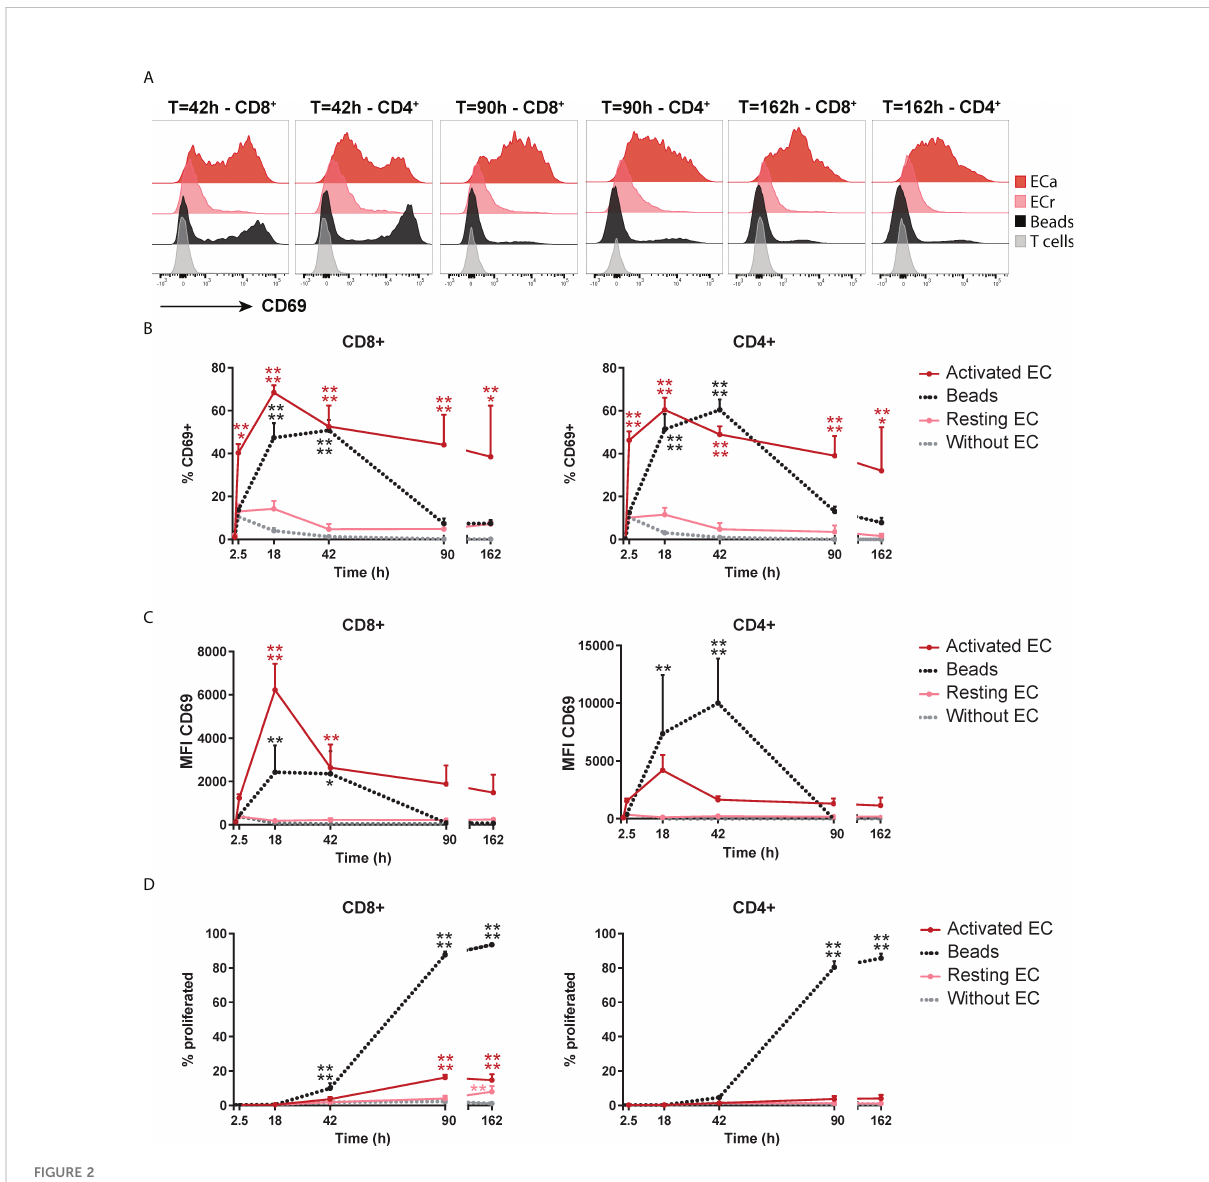
FIGURE 2 Activated EC induce a distinct dynamic of CD69 expression on T cells. HMEC were left unstimulated (resting) or stimulated with 10 ng/mL TNF a and IFN g for 3 days (activated) before addition of FACS-sorted CD3+ T cells to the co-culture. CD69 expression and proliferation were assessed at various time points of the co-culture. As a positive control, T cells were cultured with anti-CD3/CD28 beads. (A) Representative fl ow cytometry plots of CD69 expression in CD4+ and CD8+ T cells over time. (B) Percentage of CD69+ cells within CD4+ and CD8+ T cells. (C) Median fl uorescent intensity (MFI) of CD69 expression on T cells. (D) Percentage of proliferated T cells assessed by CellTrace Violet dilution assay. N = 3, mean+SEM. 2-Way-ANOVA with Sidak post-hoc test. *P < 0.05, **P < 0.01, ***P < 0.001, ****P <